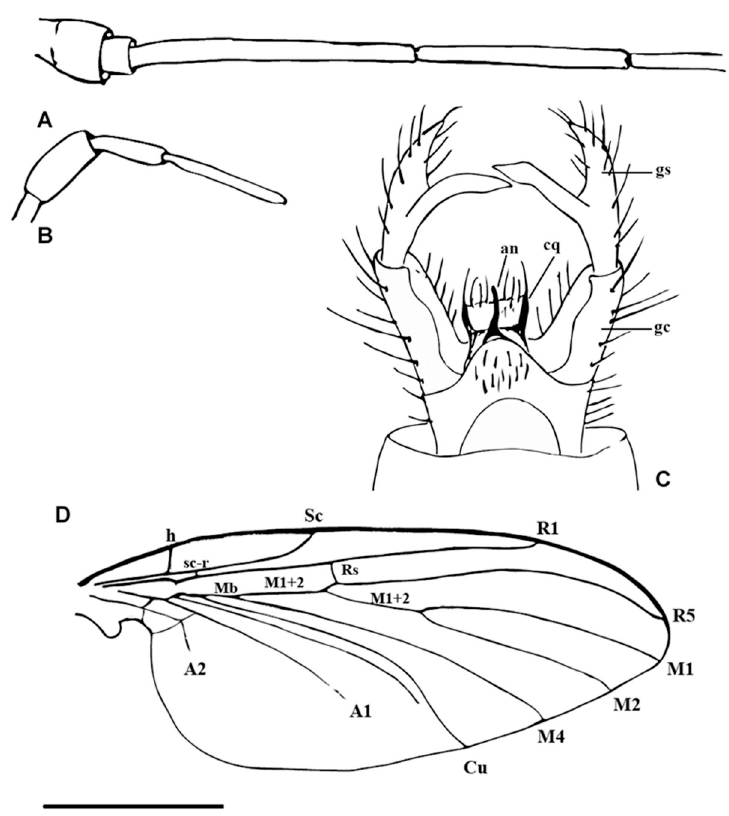
Figure 2. Line drawings of Adamacrocera adami gen. et spec. nov. ( A ) Antennae; ( B ) palpi; ( C ) male terminalia; ( D ) wing, scale: 1 mm. Abbreviations: gs—gonostylus; an—anus; cq—cerque; gc—gonocoxite; Sc—subcostal vein; sc-r—subcostal radial crossvein; h—humeral cross-vein;